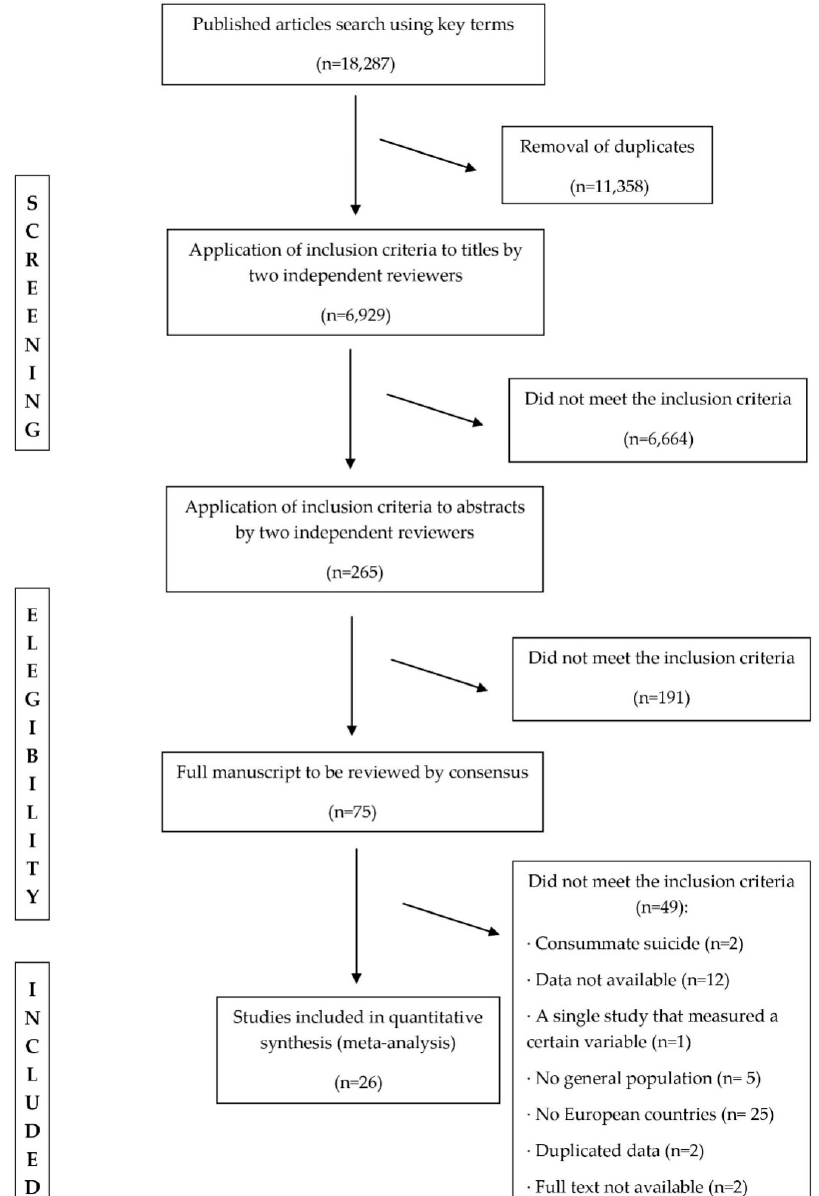
Figure 1. Study selection process.